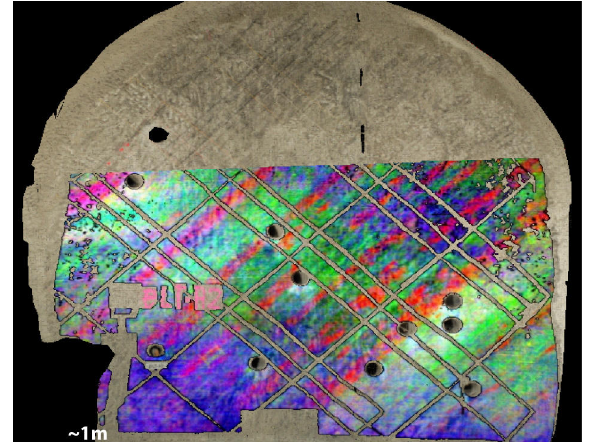
Figure 7. Result from the TT Niche; photorealistic lidar model multi-textured with a hyperspectral image product (MNF image, bands 5, 6 and 7 visualised in RGB); red colours highlight carbonate-bearing material.